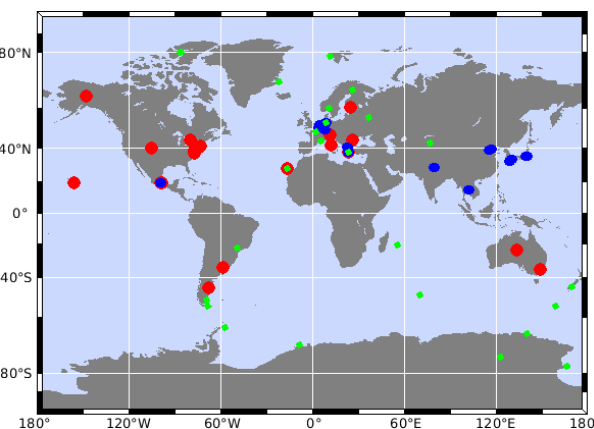
Figure 1. Geographical distribution of the UV–visible DOAS spec- trometers contributing the ground-based correlative measurements: 26 NDACC ZSL-DOAS instruments in green, 19 MAX-DOAS in- struments in blue, and 25 PGN instruments in